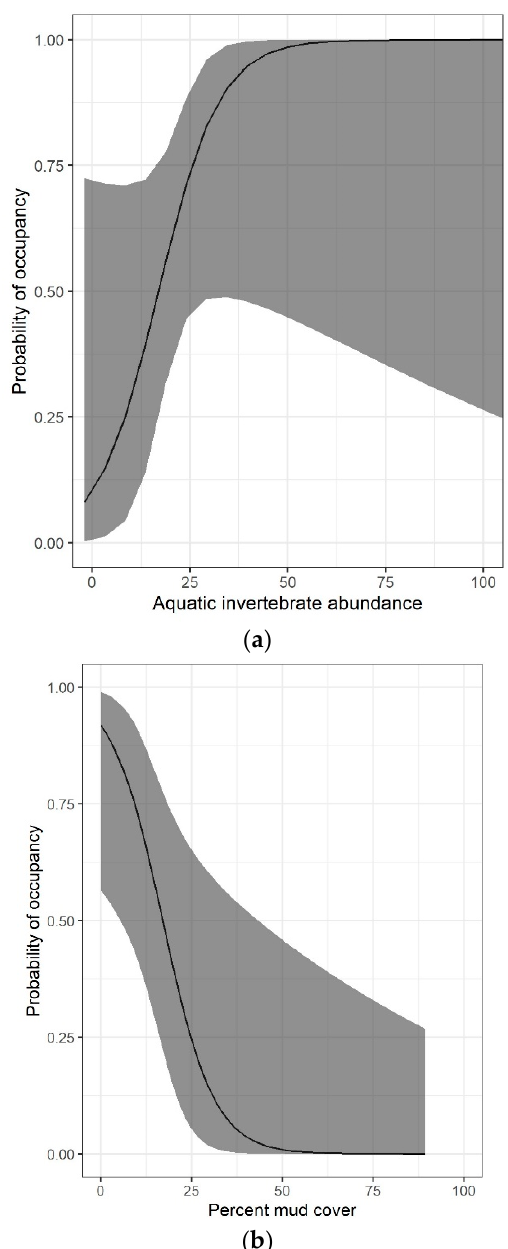
Figure 2. Relationship between probability of Rusty Blackbird occupancy and site covariates, percent cover of aquatic invertebrate abundance ( a ) and mud ( b ), with 95% confidence bands. Aquatic invertebrate richness (across all taxa) was not a predictor of Rusty Blackbird wetland use. However, it is worth noting the extent to which each taxon varied in abun- dance across our study sites as well as the difference (or lack thereof) between taxa at sites with and without Rusty Blackbird detections. Survey sites had a mean of 6.92 insect fami- lies ( ± 0.37 SE; range = 1 to 14) and a mean invertebrate count of 49.98 specimens ( ± 6.70 SE; range = 6 to 205.5) combined from three samples in 2014. Sites with Rusty Blackbird detec- tions had higher maximum invertebrate abundance of Amphipoda ( p < 0.001), Coleoptera ( p = 0.002), Collembola ( p < 0.001), Diptera ( p < 0.001), Hemiptera ( p = 0.018), Odonata ( p < 0.001), Oligochaeta ( p = 0.013), Plecoptera ( p = 0.004), and Trichoptera ( p = 0.033) than did sites with no detections (Table 4).